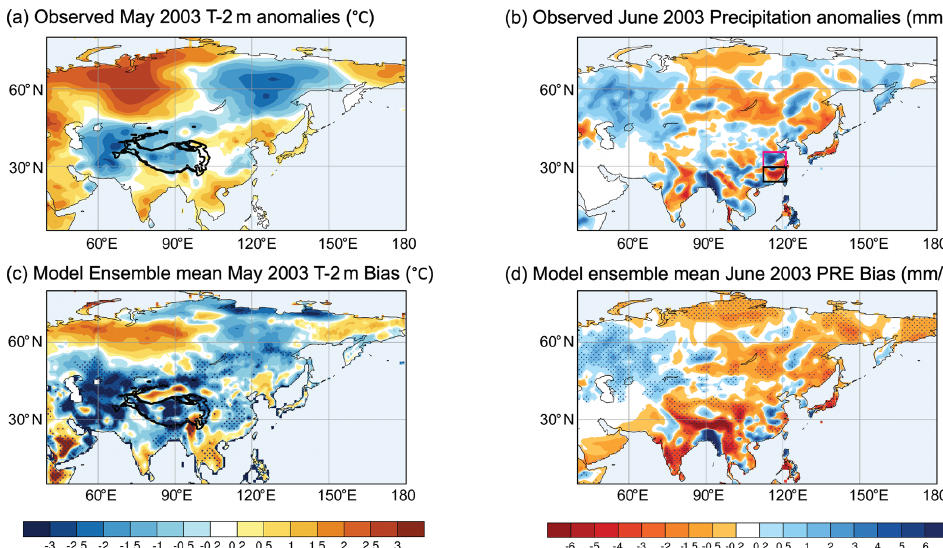
Figure 6. Comparison between the observed anomalies and the ensemble mean bias for May 2003 from 13 LS4P-I Earth system models (ESMs).